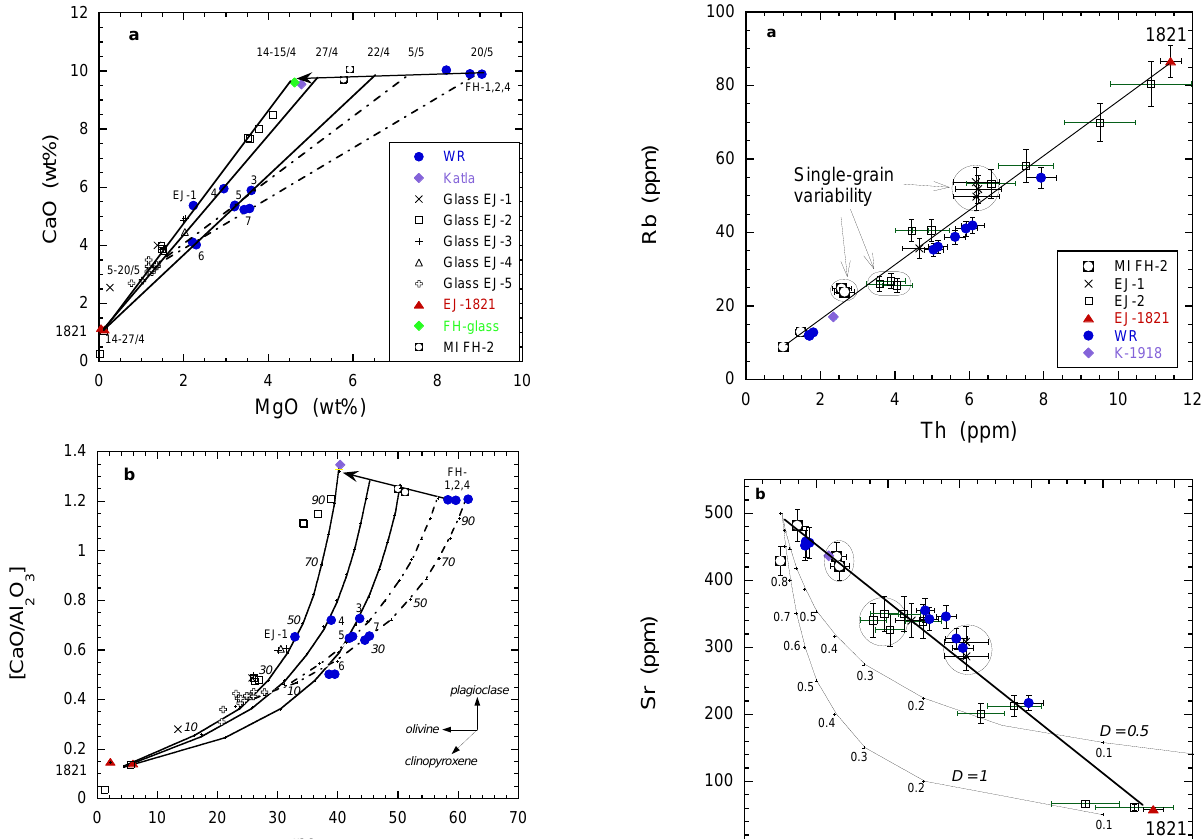
Figure 4 Sigmarsson et al.: